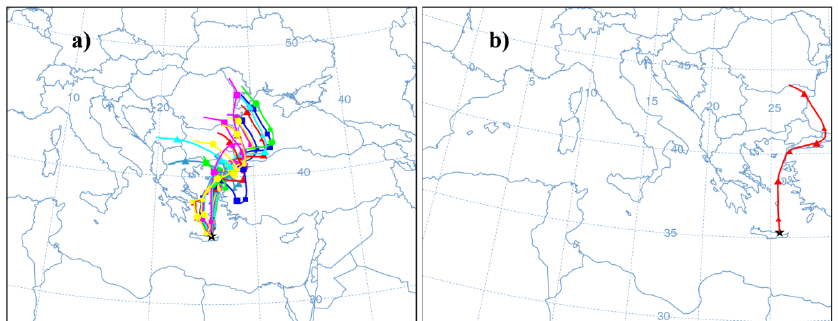
Figure 2. 72-hour back-trajectories calculated in HYSPLIT with WRF gridded meteorological input data for parcels arriving at the Finokalia site during the FAME-08 campaign on 15 May 2008 at 05:00p.m.UTC. (a) 20 back-trajectories are simulated with varying arrival altitude. (b) These paths are then combined with the HYSPLIT clustering utility to estimate one representative trajectory for the parcel’s horizontal path.